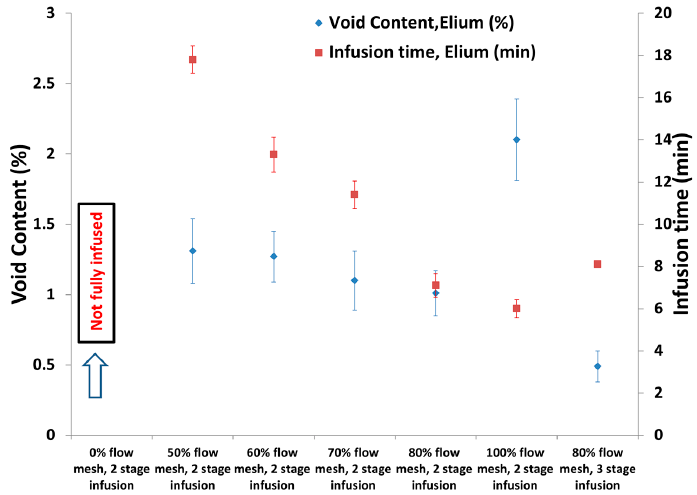
Figure 11. Void Content and infusion time at two-stage and three-stage vacuum level with varied flow mesh length for thin C-Ply™ with TP matrix.